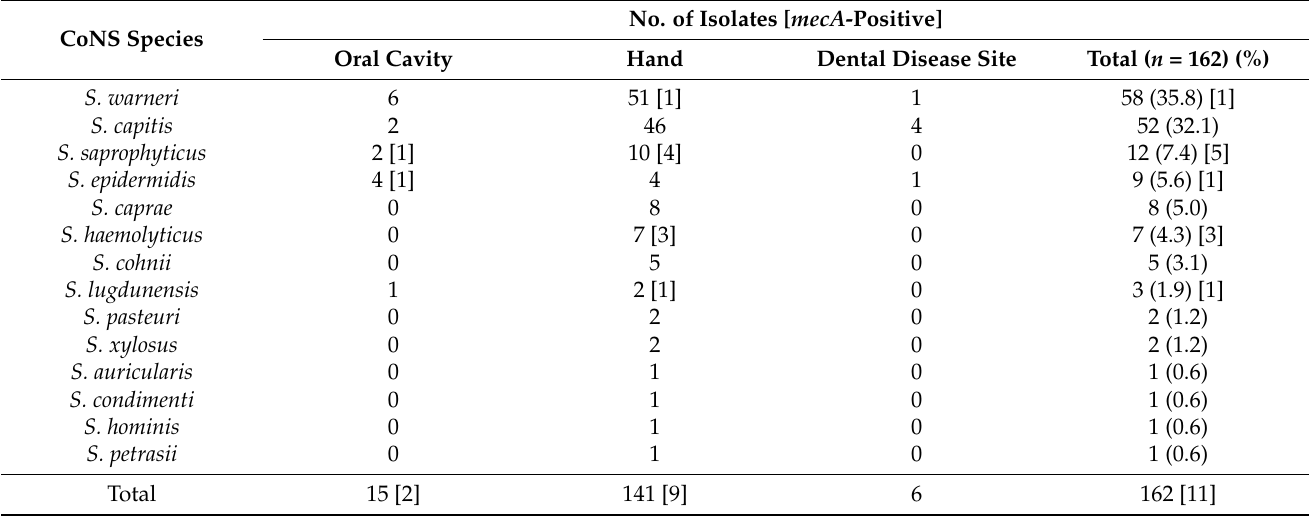
Table 4. Species of CoNS isolated from